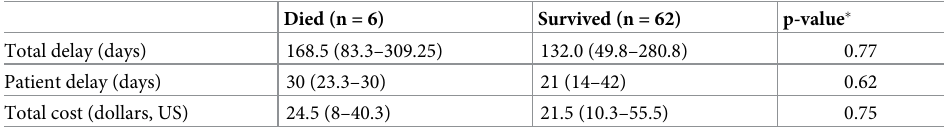
Table 3. Association between delay, cost and 24-month